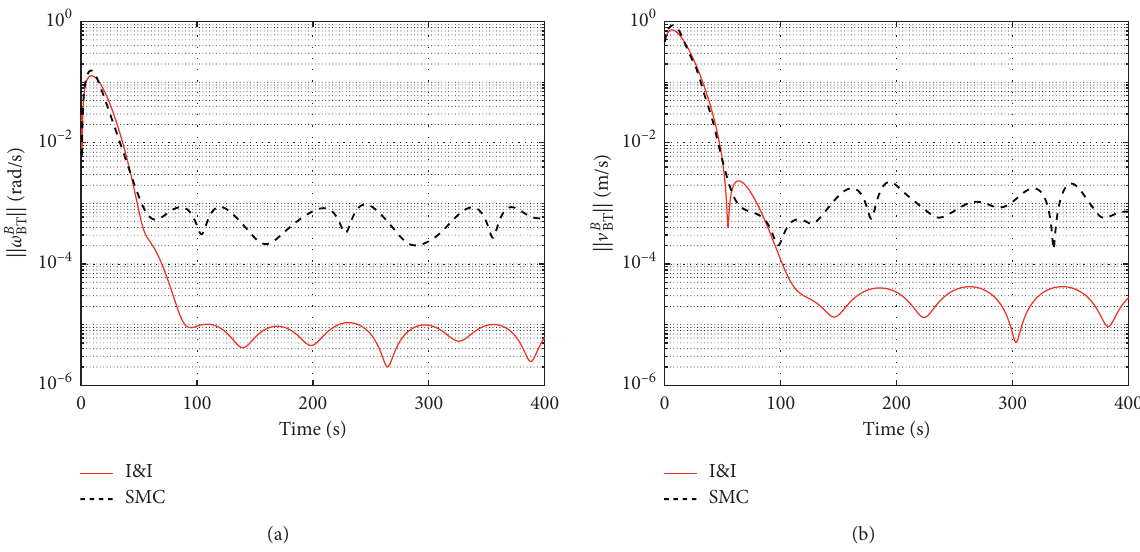
Figure 12: Relative dual velocity norms under different controllers.